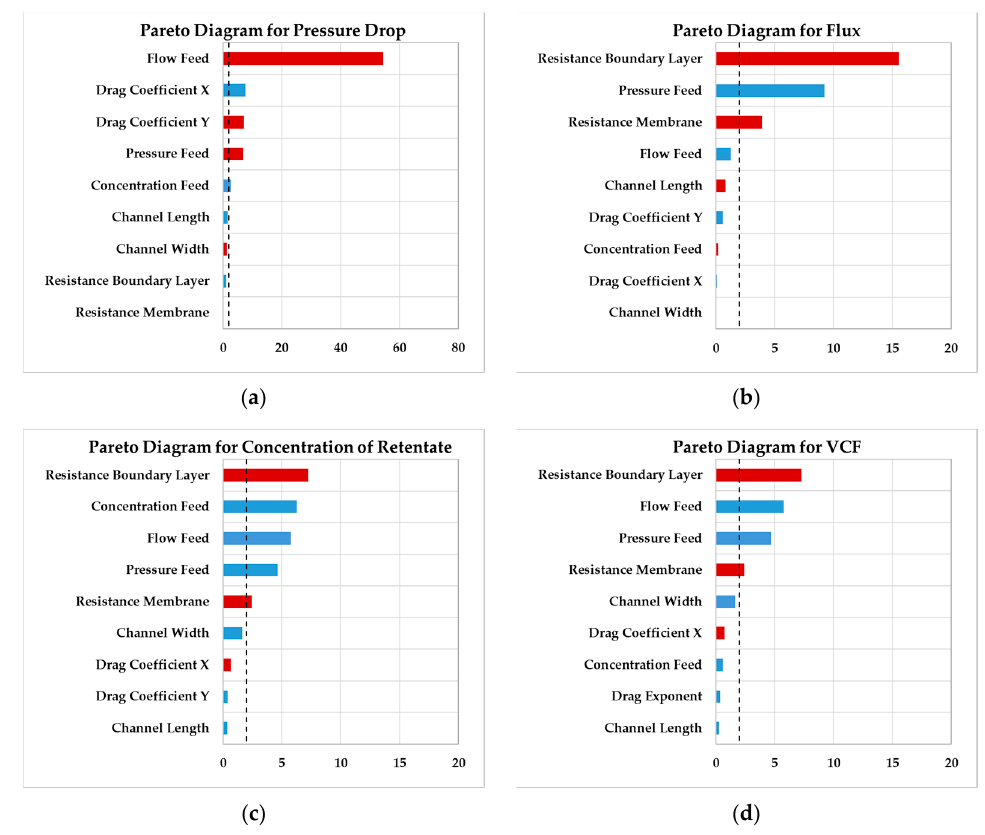
Figure 5. Sensitivity study—Pareto diagrams for ( a ) pressure drop ( b ) flux ( c ) concentration of retentate ( d ) volumetric concentration factor (VCF)—positive t -ratios are marked blue and negative ones are marked red.